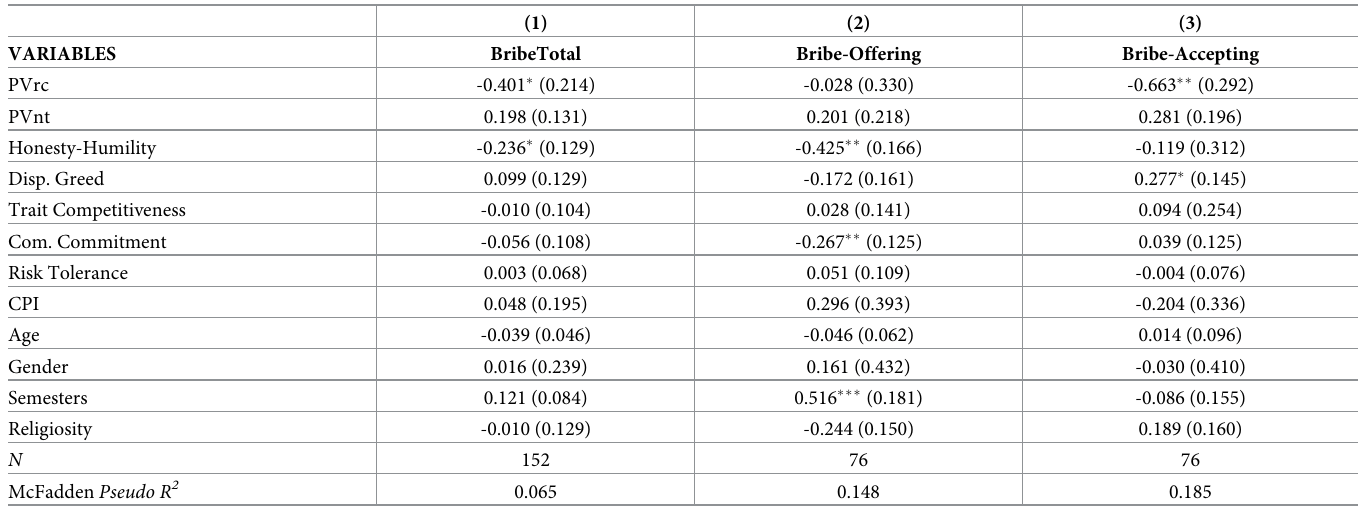
Table 4. Robustness analyses of engagement in